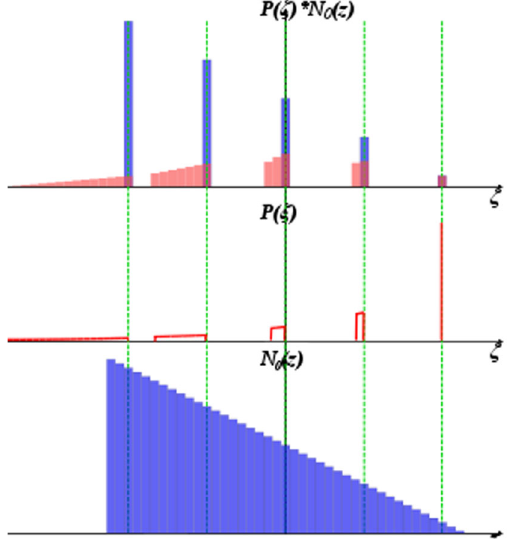
FIG. 16. The y 2 0 -series perturbation for the case of C 11 < 0 . Bottom: The ideal n 0 ð z i f Þ profile. Middle: The perturbation function, P ð ζ Þ , for the y 2 0 -series with C 11 < 0 . Top: Slices of the ideal profile n 0 ð z i f Þ (blue) and the perturbed profile n ð z p f Þ (red). The skewed Gaussian spread of the slices gets stronger the farther away from the